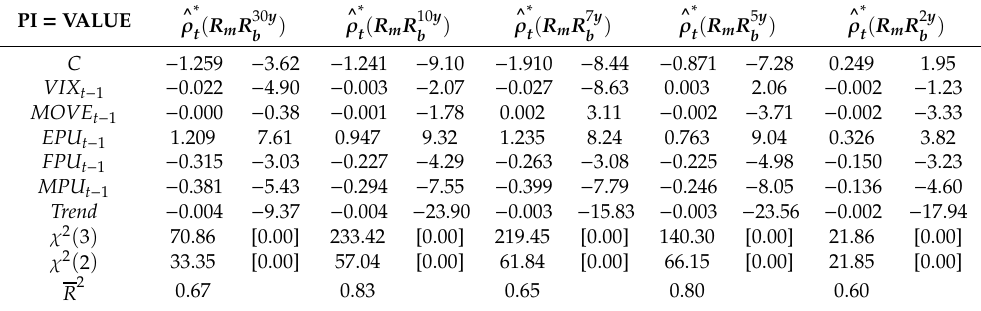
Table 8. Estimates of aggregate and categorical EPU, FPU, and MPU and on stock (VALUE)–bond return